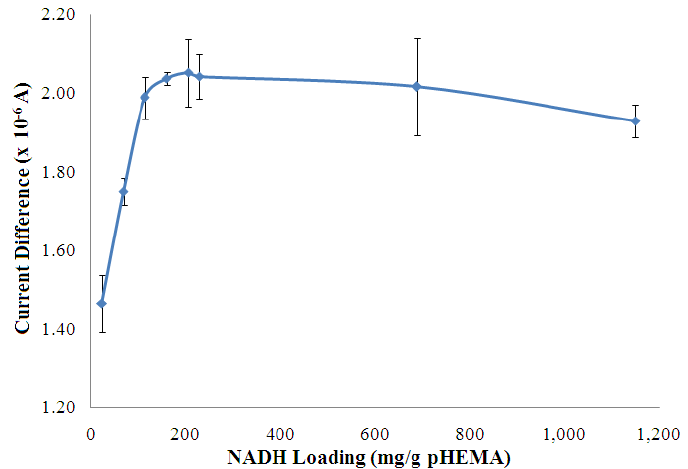
Figure 9. The response of the NH 4+ ion biosensor to various amount of NADH entrapped in a pHEMA membrane on the response of the NH 4+ ion biosensor (100 mM NH 4+ ion at pH 7) (n =